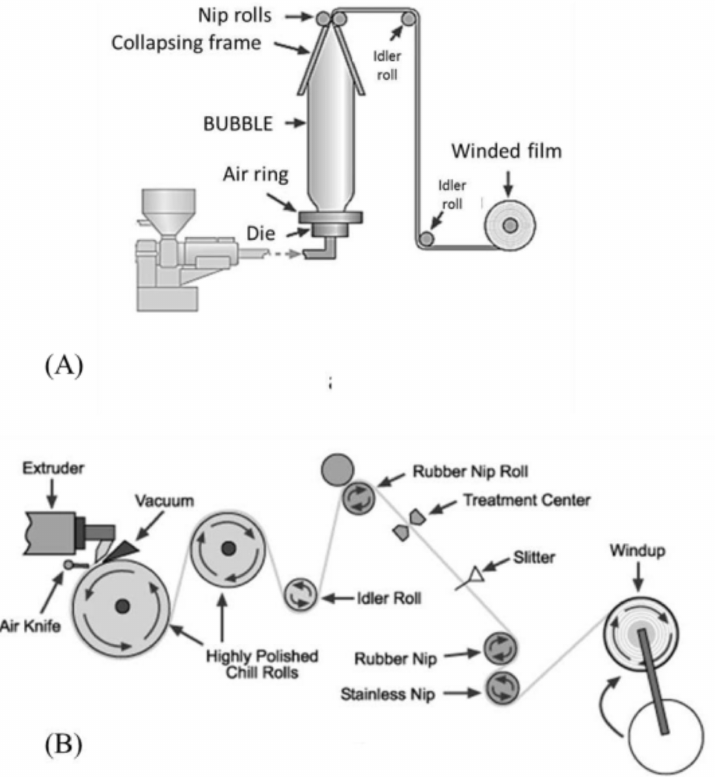
Figure 3. Schematic of the film extrusion/co-extrusion lines: ( A ) blown film extrusion line and ( B ) cast film extrusion line. Reprinted from Covas, J., & Hilliou, L. (2018). Chapter 5—Production and Processing of Polymer-Based Nanocomposites. In M. Â . P. R. Cerqueira, J. M. Lagaron, Copyright (2018), with permission from